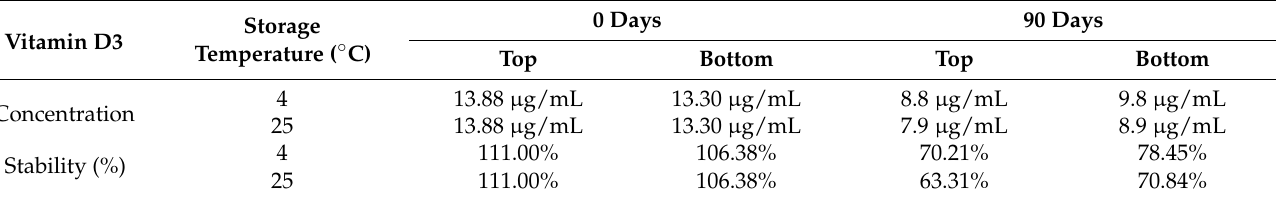
Table 5. Stability of lipid-based vitamin D3 upon storage at 4 ◦ C and 25 ◦